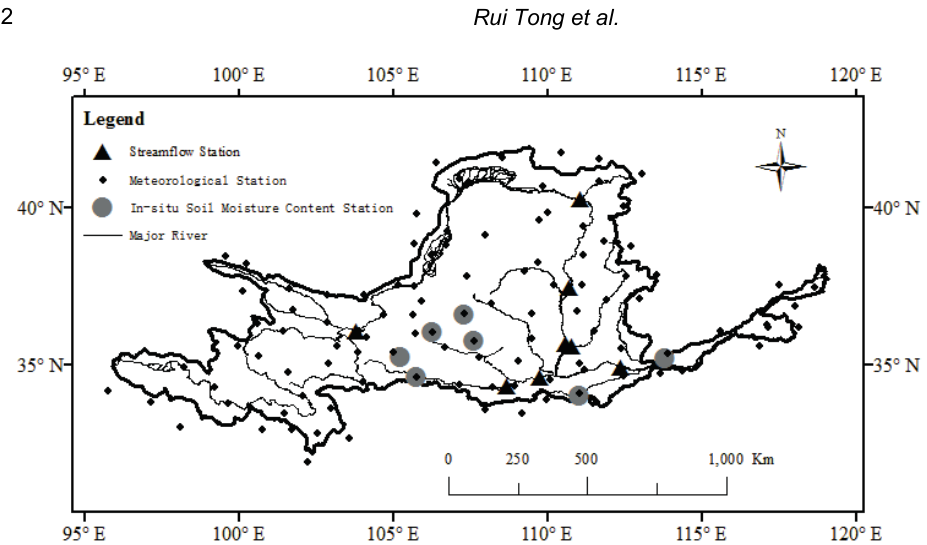
Fig. 1 The Yellow River basin and the geographical distribution of the stations used in this